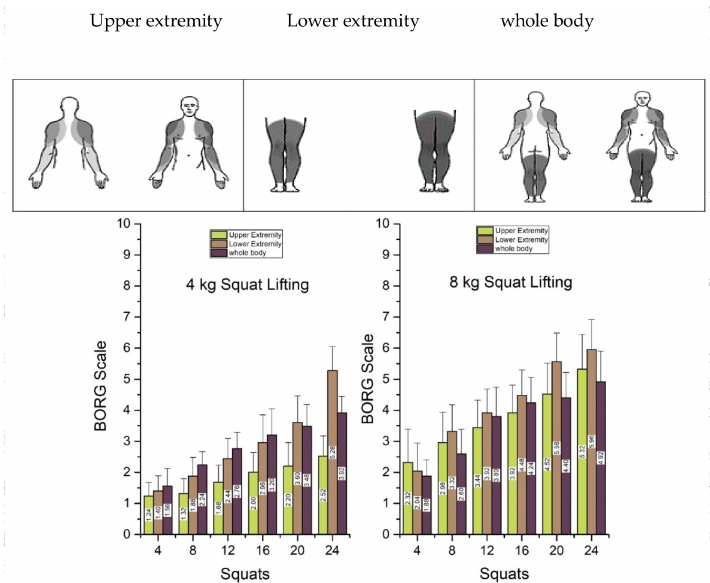
Figure 3. Borg scale readings for upper and lower extremity and whole body for the 4 kg and 8 kg weights. Grey areas are highlighted to represent the perceived regions for the response against the Borg scale.